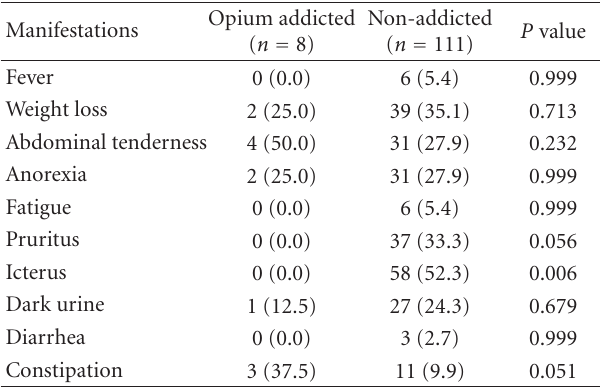
Table 2: Clinical manifestations in opium-addicted and non- addicted patients with SOD and undergoing